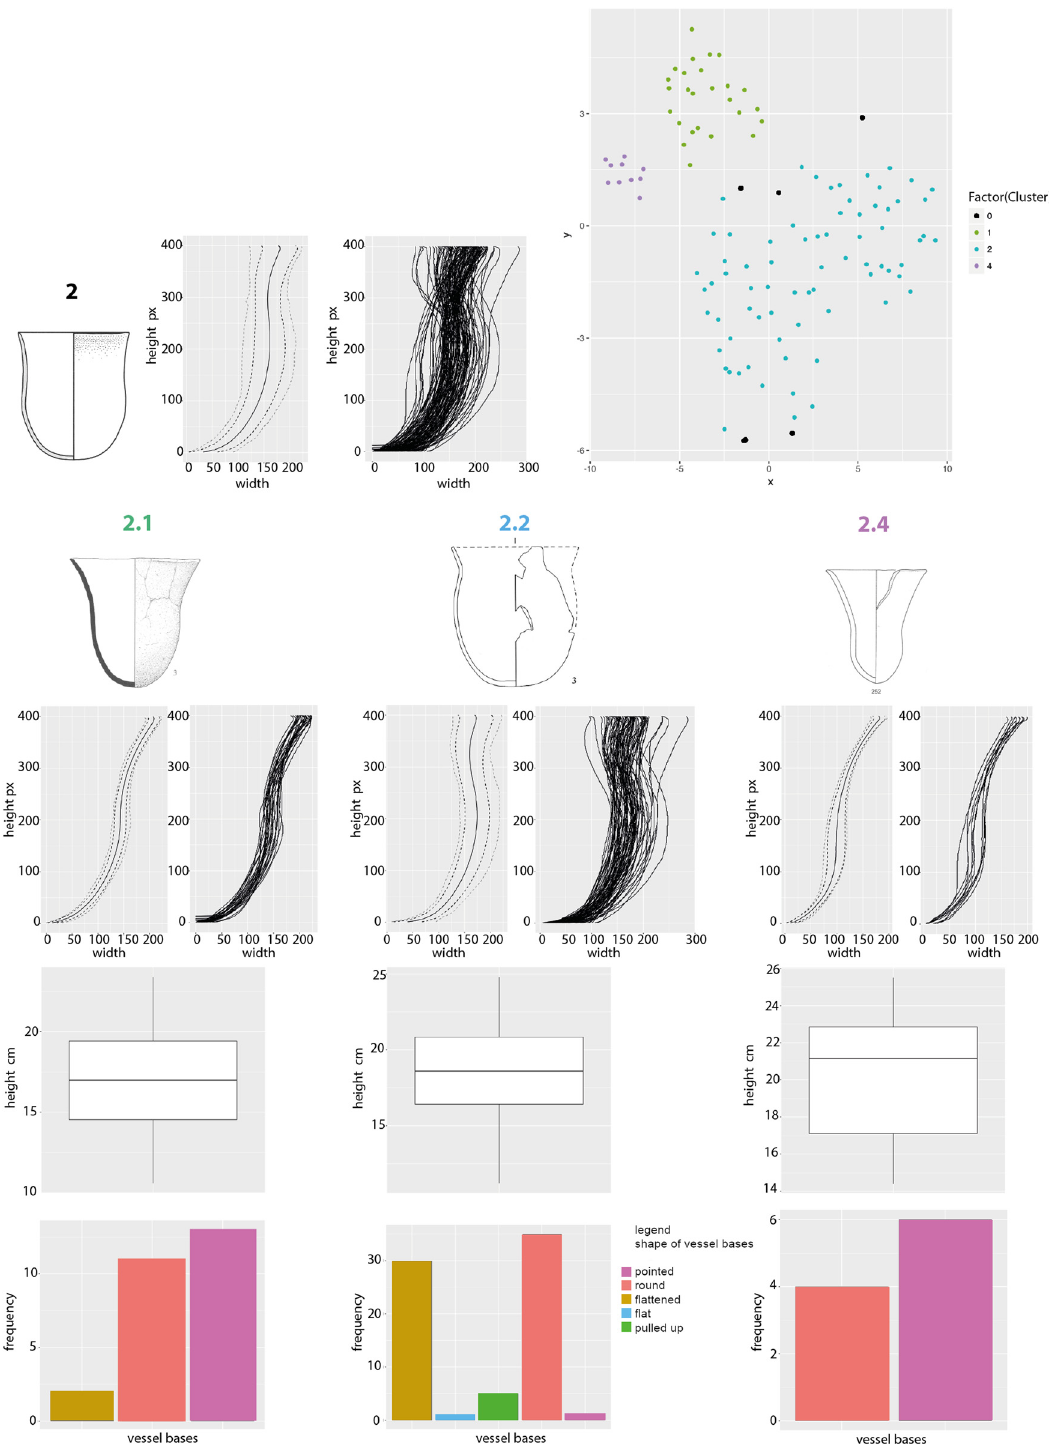
Figure 10: Cluster 2 and subclusters 2.1, 2.2, and 2.3 ( fi gure: M. Hinz and C. Heitz, for the picture credits of the pottery drawings, see doi: 10.5281/zenodo.7258694 )